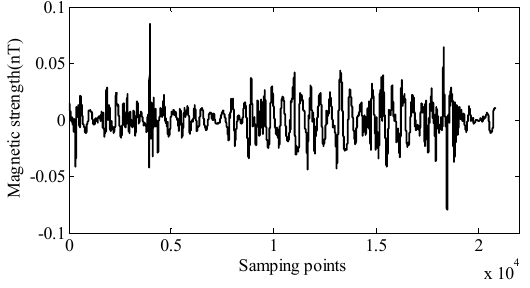
Figure 9. The geomagnetic gradients interference field.